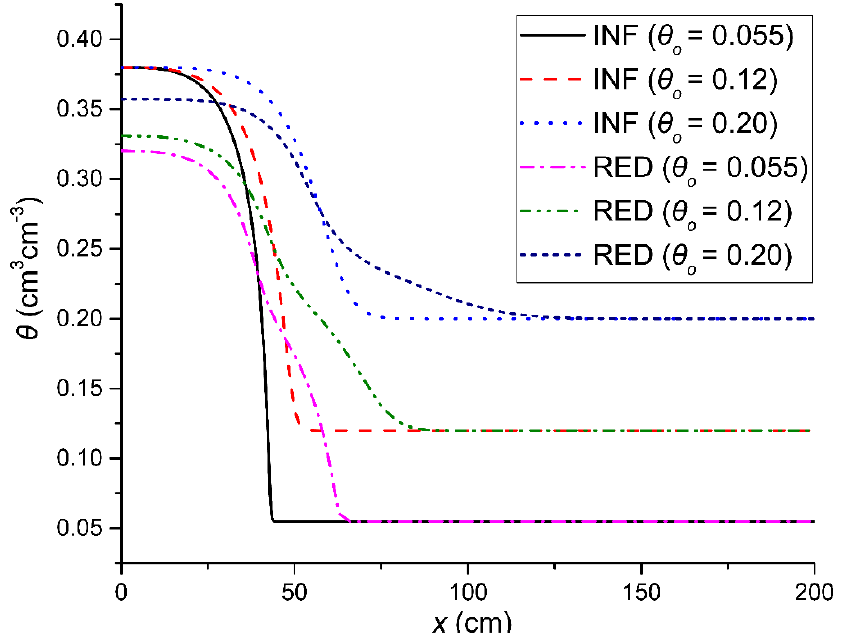
Figure 10. The soil water content profiles of the initial horizontal infiltration (INF) with duration T = 25 min and of the redistribution (RED) for time t = 75 min after the cessation of the infiltration for different values of initial water content lying at the boundary wetting curve before the commencement of the initial infiltration ( θ o = 0.055, θ o = 0.12, and θ o = 0.2 cm 3 cm − 3 ).